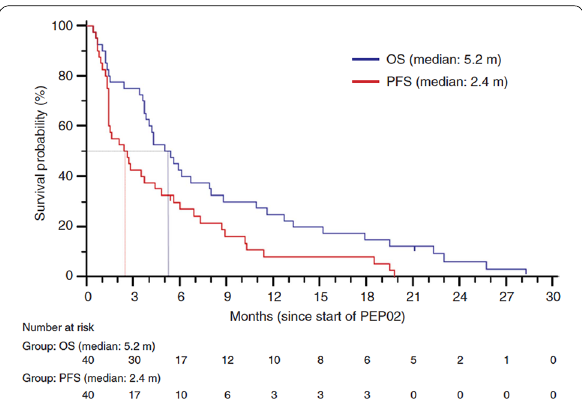
Fig. 7 Kaplan–Meier curves of overall and progression‑free survival. Abbreviations used are m for months, OS for overall survival, and PFS for progression‑free survival (Reproduced with permission from